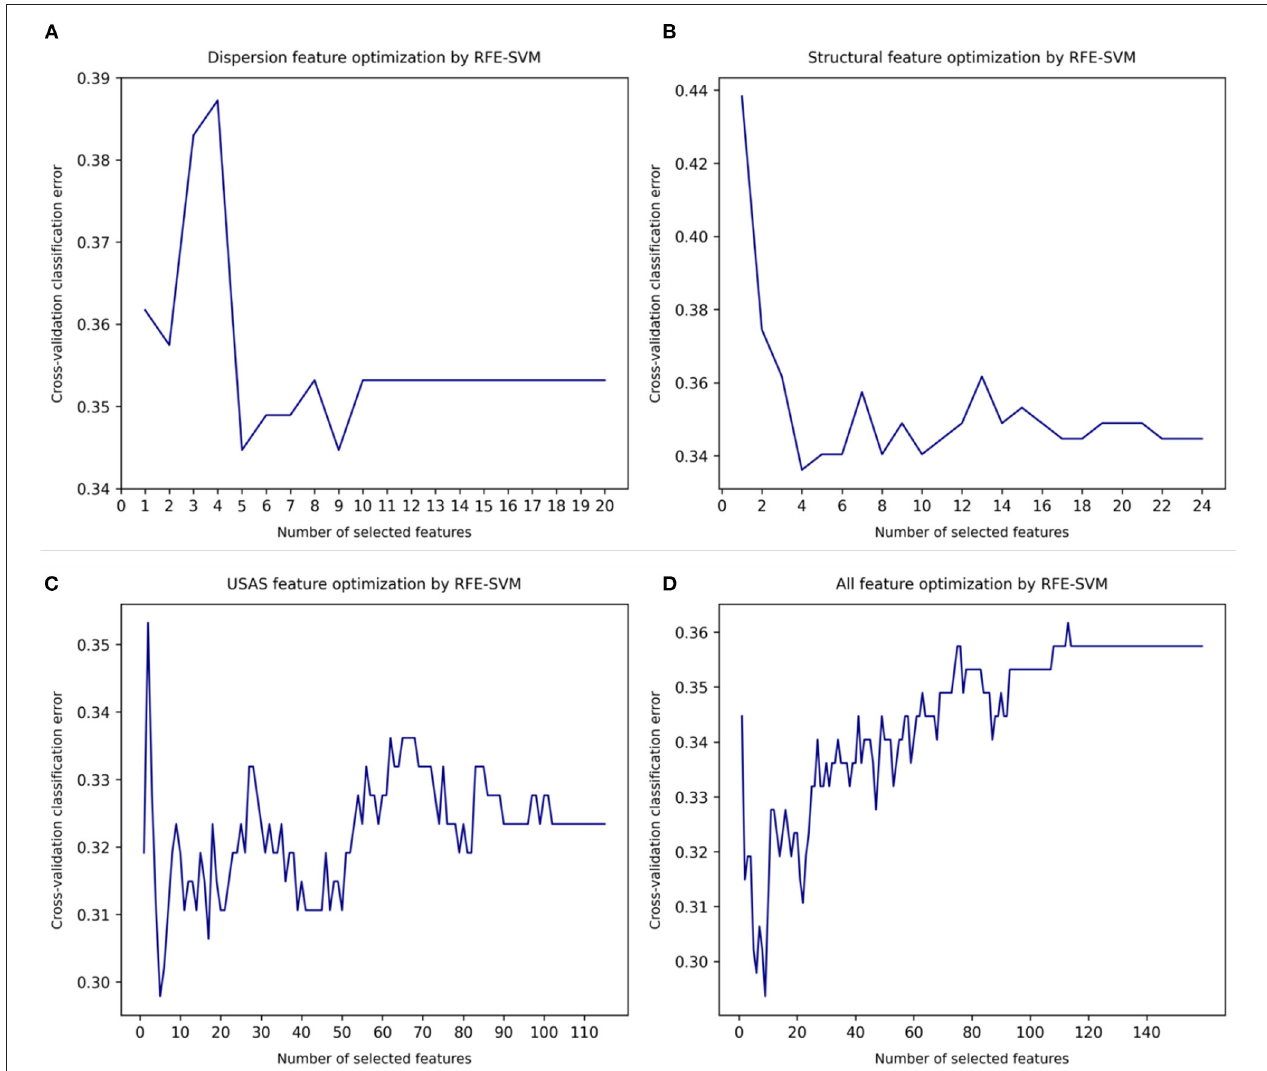
FIGURE 1 | Automatic feature optimisation. (A) Lexical dispersion rate feature optimization. (B) Structural features optimization. (C) English semantic feature optimization. (D) Joint optimization of all features.